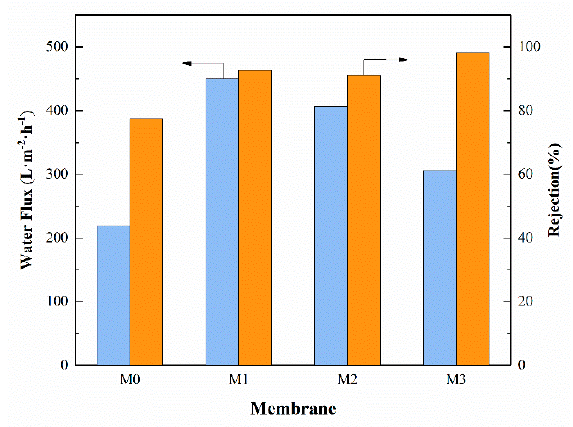
Figure 7. Pure water flux and bovine serum albumin (BSA) rejection of the MXene/polysulfone (PSF) membranes.